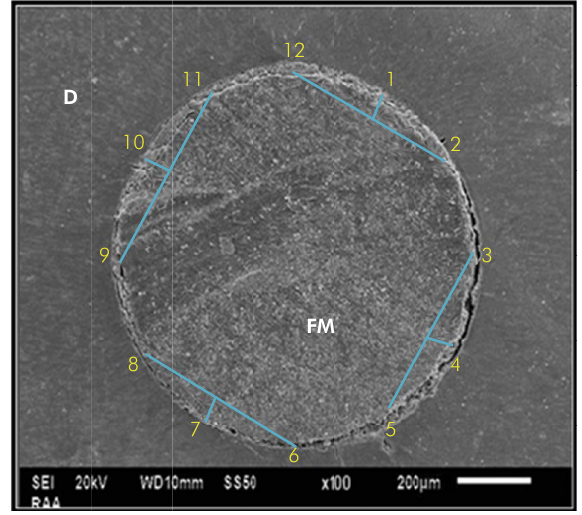
Figure 2. Assessing the presence of gaps on 12 points at the interface between dentin (D) and filling material (FM) using SEM